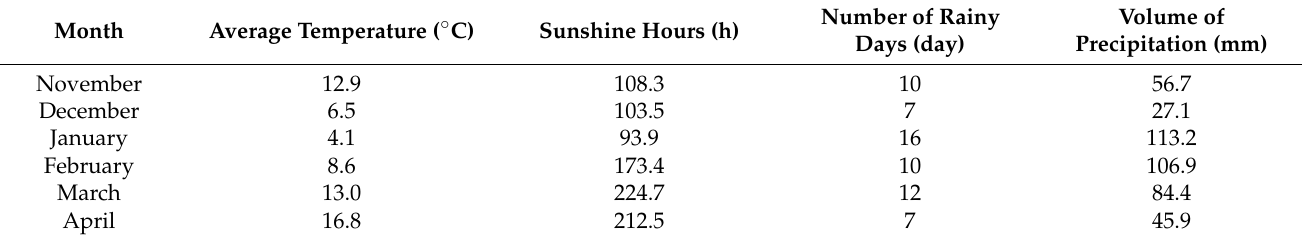
Table 1. Meteorological data for Wuhan City by month from November 2019 to April 2020. Data obtained from Wuhan Statistical Yearbook 2020 and 2021 (available online: http://tjj.wuhan.gov.cn/ tjfw/tjnj/, accessed on 21 June